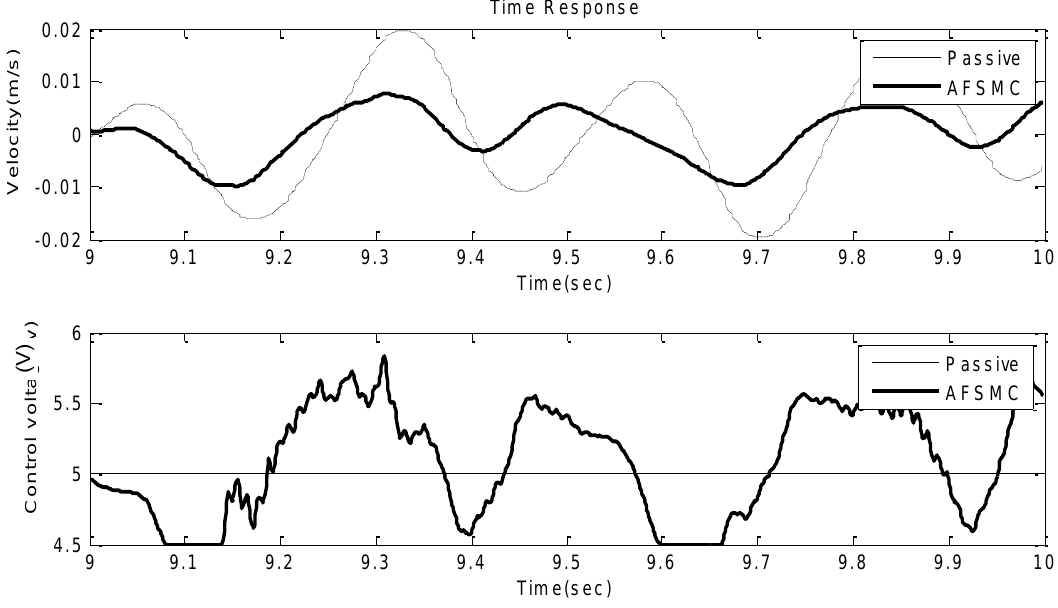
Figure 9. Time domain velocity response (upper) and control voltage (lower) of the passive and AFSMC-active isolator under random disturbance (9–10 s).